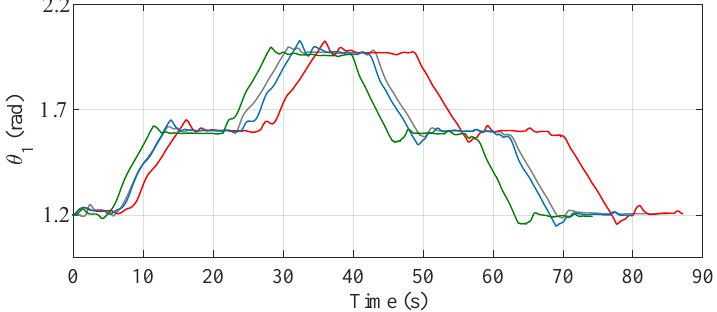
Figure 25. Behavior of θ 1 when the optimization is carried out with α = 0 ( — ), α = 0.5 ( — ) and α = 1 ( — ) and when the optimization is not considered ( —